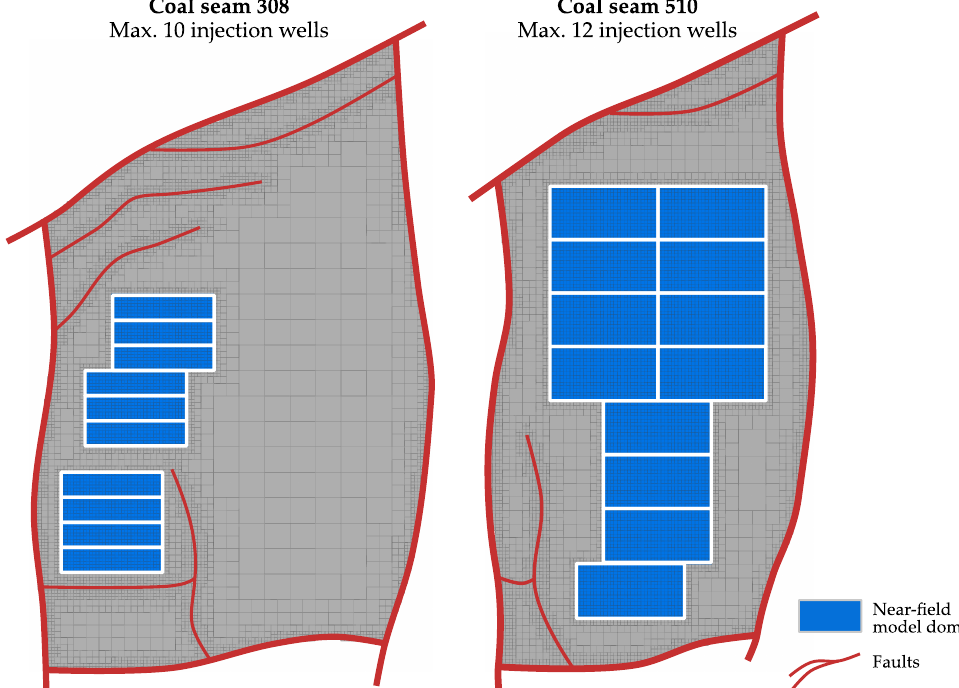
Figure 5. Injection well arrangement for coal seams 308 and 510 with 10 and 12 panels, respectively. The near-field model domain (blue) has an extent of 200 m × 800 m and 400 m × 800 m for seams 308 and 510,